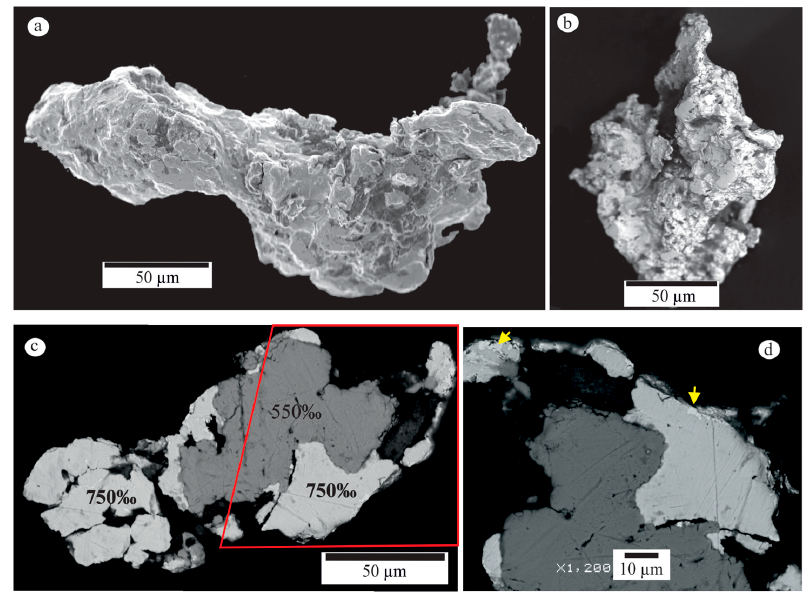
Figure 5. Morphology and features of the internal structure of slightly rounded gold of the Billyakh river placer: ( a ) slightly rounded gold particle; ( b ) angular, lumpy gold with an rough porous surface; ( c ) block nature of the internal structure of multiphase gold (detalized area marked in red); ( d ) detalized area: multiphase gold, the yellow arrows show the high-fineness phase, etched with a reagent based on aqua regia; ( a , b ) shot in SEI mode; ( c , d ) shot in BSE mode.